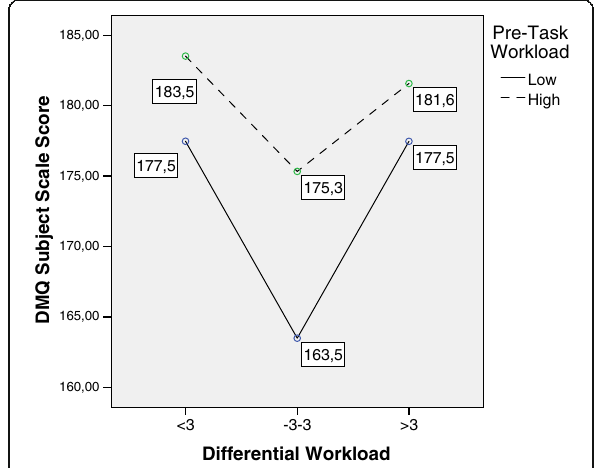
Fig. 4 MANOVA. Estimated marginal means. Differential Workload vs.